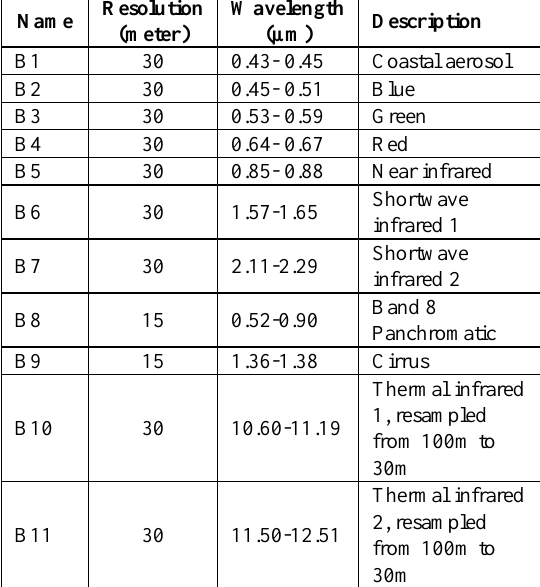
Table 1 . Band Specifications USGS Landsat 8 Collection